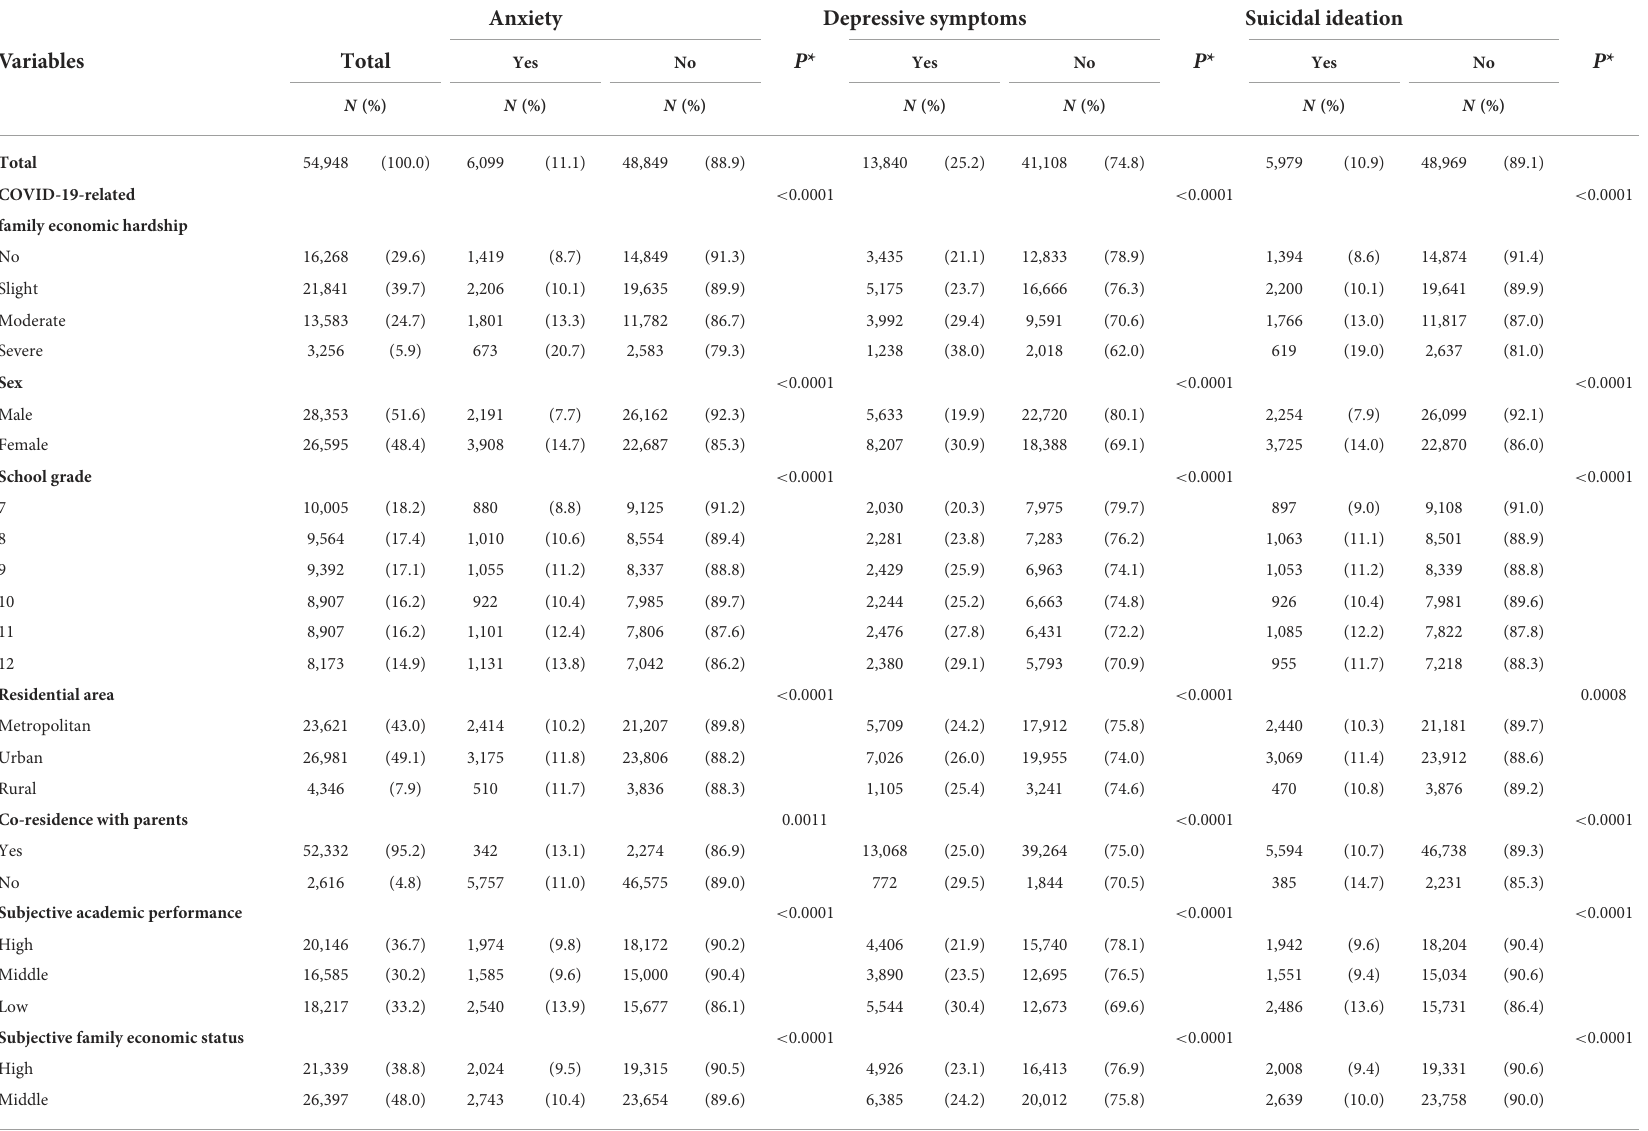
TABLE 1 General characteristics of the Korean adolescents included in the analysis ( N =